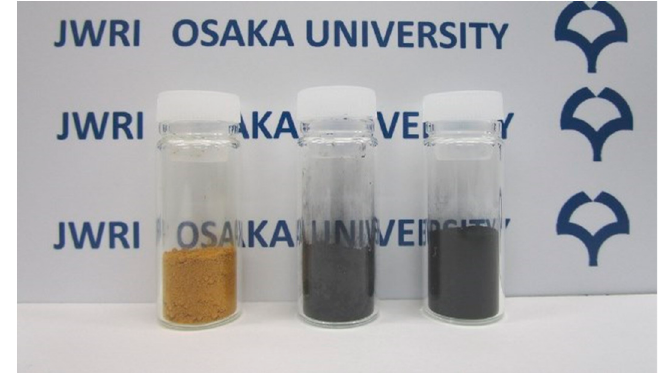
Figure 1. Photographs of ( left ) α -FeOOH powder used as a precursor; ( center ) the product prepared by reducing α -FeOOH in the mixed solvent with 9 vol. % water concentration at 200 °C for 24 h; ( right ) the product prepared by reducing α -FeOOH with 12 vol. % water concentration at 200 °C for 48 h.